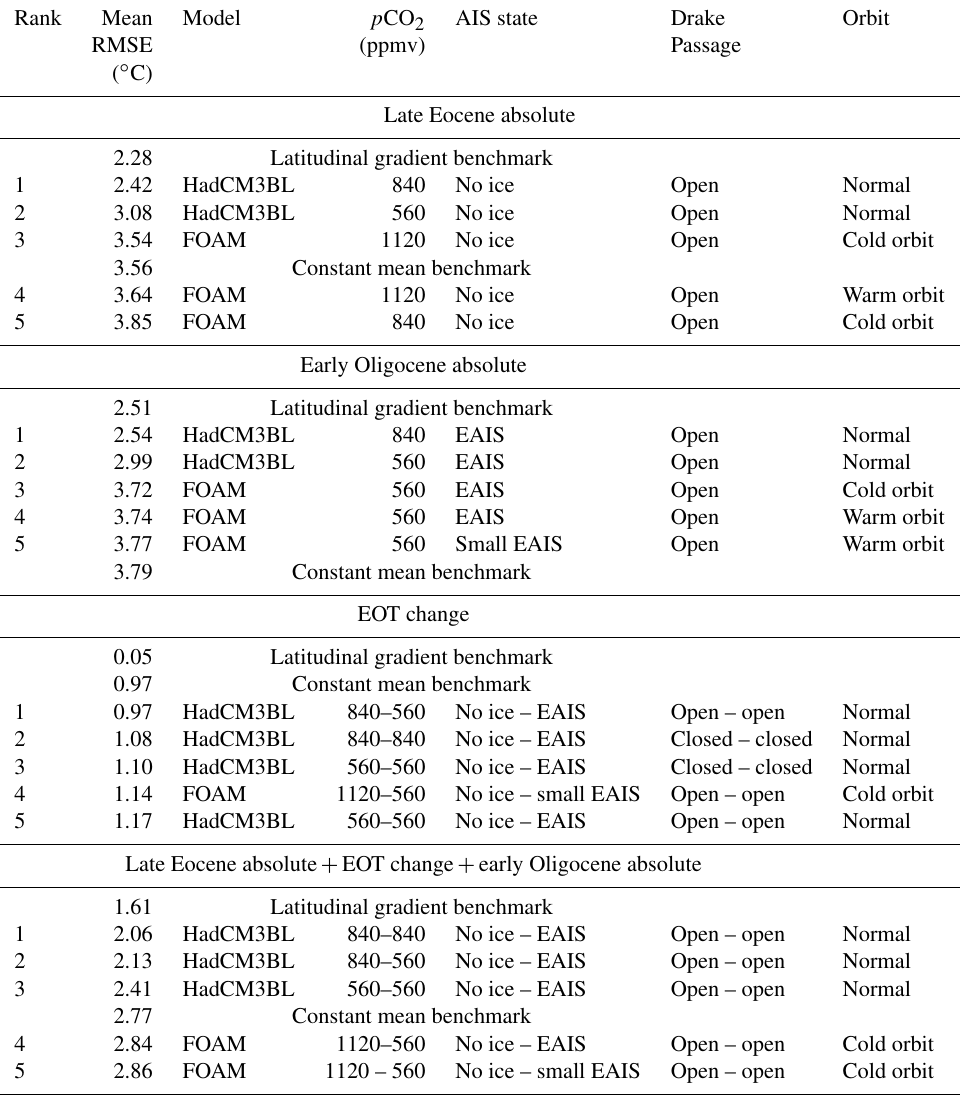
Table 2. The five highest ranked simulations (or simulation pairs) in terms of mean standard and normalized RMSE for each time slice and across all three time